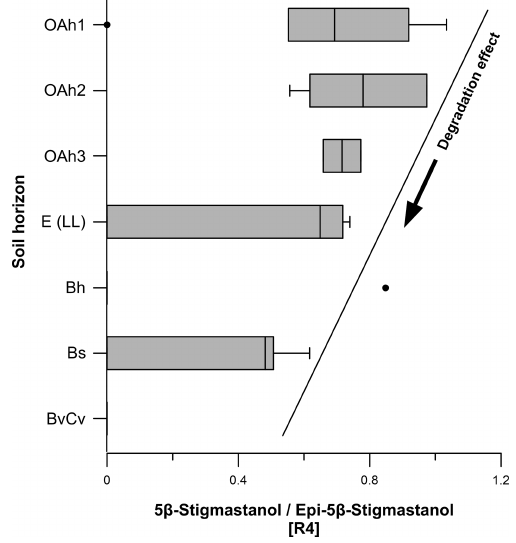
Figure 8. Microbial transformation of 5 β -stigmastanol to epi-5 β - stigmastanol (ratio 4). Epimerization of 5 β -stanols (“degradation effect”) takes place over time due to microbial processes in soils (Bull et al., 2001; Prost et al.,